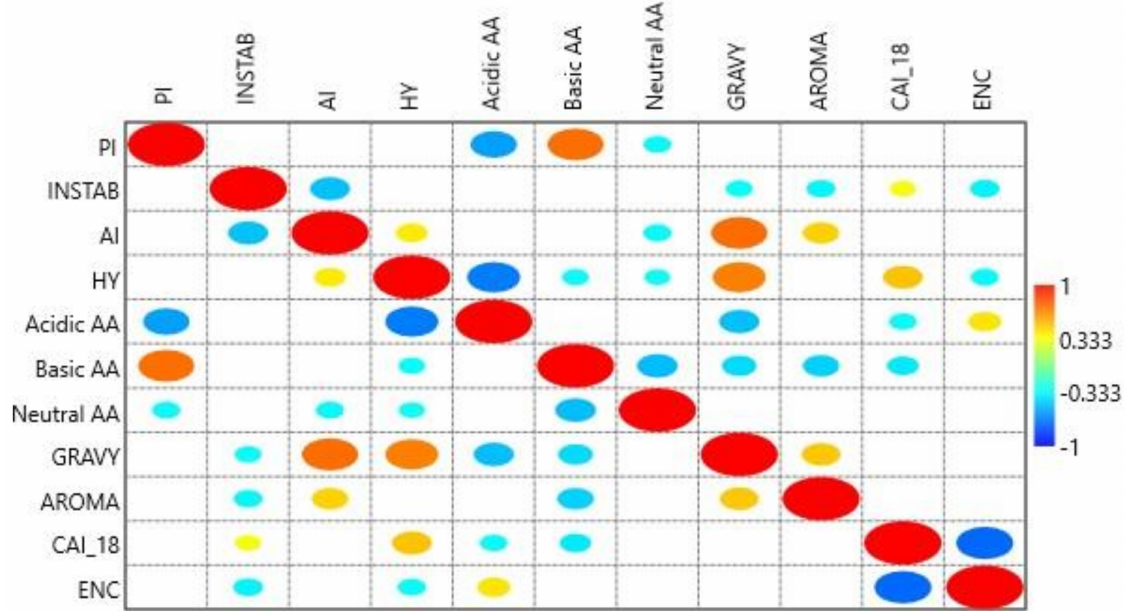
Figure 14. A mirror image plot depicting the correlation between CAI-18 and different protein indices. A bigger-sized eclipse described a higher Pearson’s correlation coefficient (r) value, and vice versa. The red color shows a positive correlation, whilst blue indicates a negative correlation. Empty boxes show an insignificant